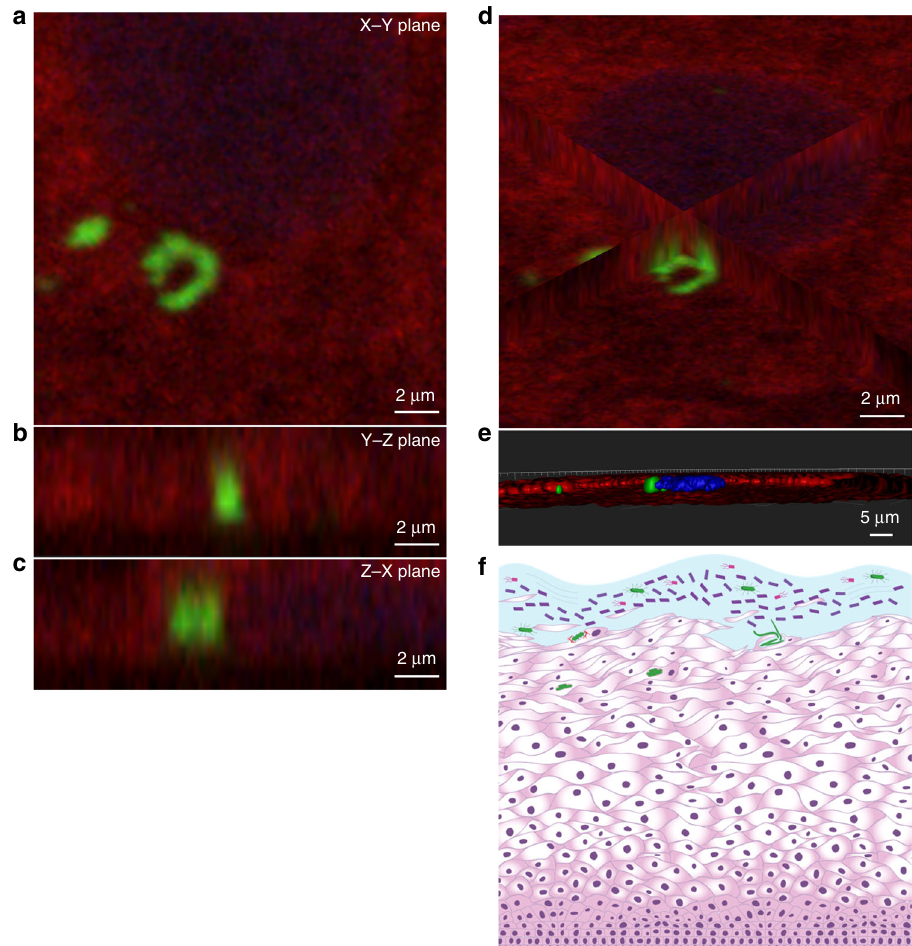
Fig. 4 UPEC invades the VECs of women with a history of rUTIs. For this pilot study, immuno fl uorescence microscopy was used to search for E. coli within VEC collected by vaginal swabbing of four women with a history of rUTIs. a – d For immuno fl uorescence, samples were stained with an α - E. coli (green), cytokeratin 13 (red), and α -uroplakin III (yellow) and ToPro-3 (blue). a The XY -plane image from a Z-stack series of a VEC with E. coli surrounded by the VEC-speci fi c cytokeratin 13. Ortho views of b YZ -plane and c XZ -plane reconstructed from a Z-stack series images showing E. coli surrounded by cytokeratin 13 within a VEC near the nucleus. d Ortho-view of images mid-way through the VEC demonstrating the internal localization of invading E. coli on all three dimensions. e Surface reconstructions of E. coli , VEC cytokeratin 13, uroplakin III, and nucleus that shows that the nucleus and E. coli are within the cytokeratin 13 of the VEC. Imaris software was used for image analysis. f Illustration depicting invasion of the vaginal epithelium by UPEC (green